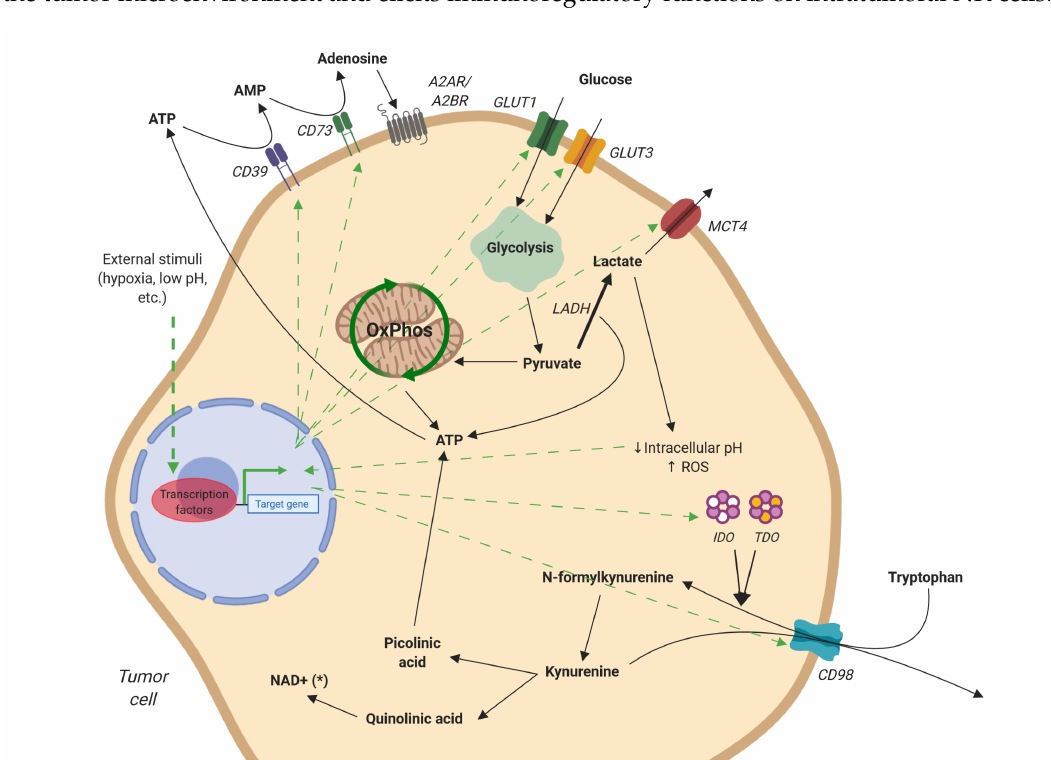
Figure 3. Metabolism of adenosine, glucose, and tryptophan by tumor cells. Free adenosine is produced by the cleavage of extracellular ATP by CD39 and CD73. Signaling through A2AR, adenosine initiates an anti-inflammatory response. Glucose uptake is increased, via GLUT1/3, after which it is converted to pyruvate via glycolysis. Excess pyruvate is transformed into lactate and either exported by MCT4 or remains in the cytoplasm, decreasing cellular pH, resulting in ROS production. Tryptophan, transported by CD98, is transformed to kynurenine by IDO and TDO. Kynurenine is either released from the cell via CD98 or further processed to quinolinic acid and picolinic acid. These intermediates can be used for the generation of NAD+ and ATP, respectively. Green arrows represent stimulation or upregulation. Figure created with